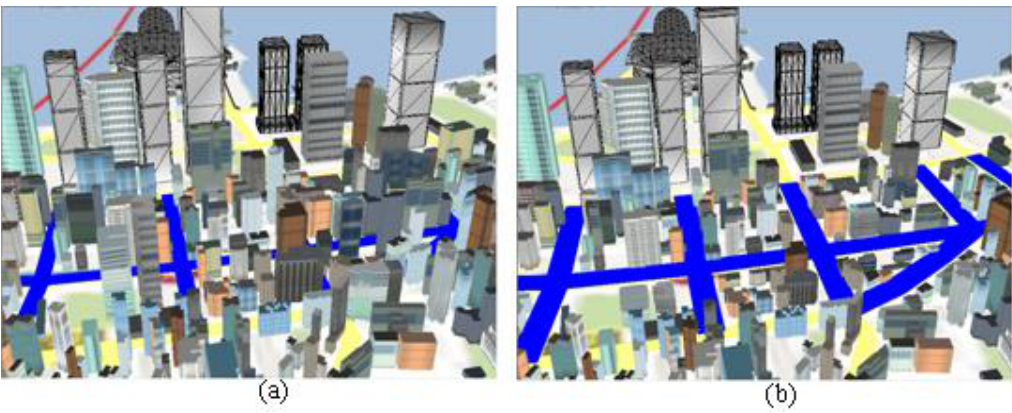
Figure 9. A road in Vancouver: ( a ) original perspective view with occluded intersections; and ( b ) occlusion-free view showing clear intersections.